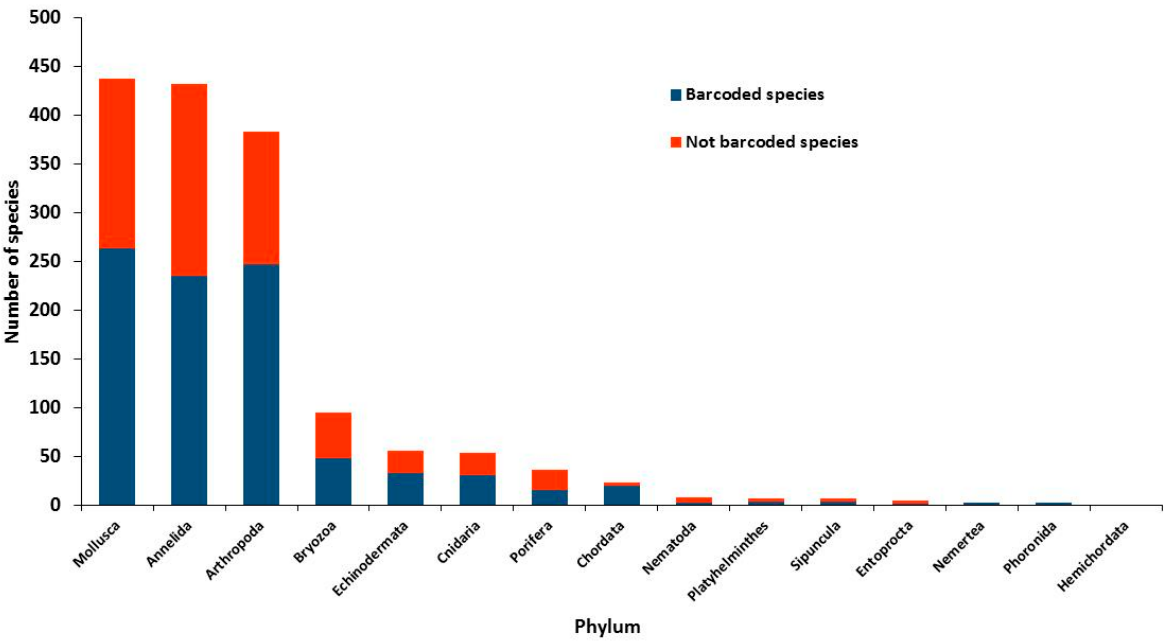
Figure 1. The number of barcoded and not barcoded macroinvertebrate species for each phylum retrieved from the aquatic ecosystems of Apulia Region (Southeast of Italy).